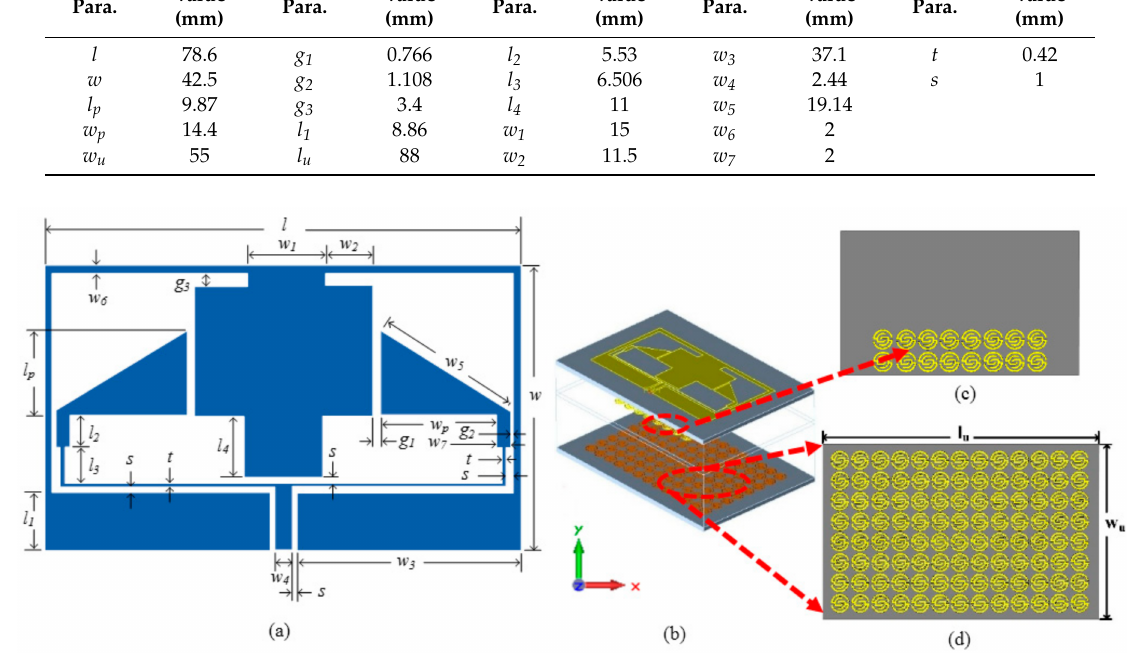
Figure 8. Geometry of the proposed antenna: ( a ) front view, ( b ) 3D view, ( c ) back view, ( d ) suspended separator metamaterial (MTM)